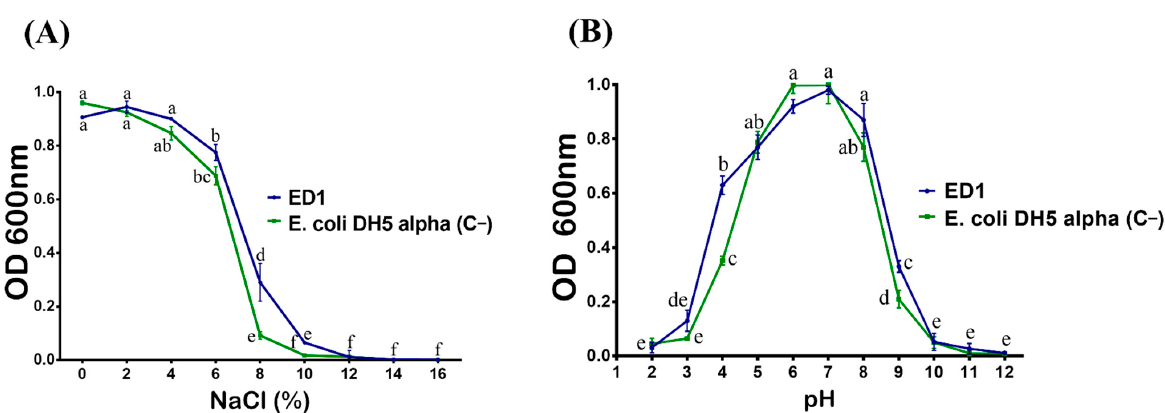
Figure 3. Effect of NaCl ( A ) and pH ( B ) on the growth of the S. rubidaea ED1 strain. Media inoculated with Esherichia coli DH5 α were used as a negative control (C − ). The values represent means of three replicates ( n = 3) ± SD. The different letters in superscript (a–f) indicate the statistically significant difference at 95% between